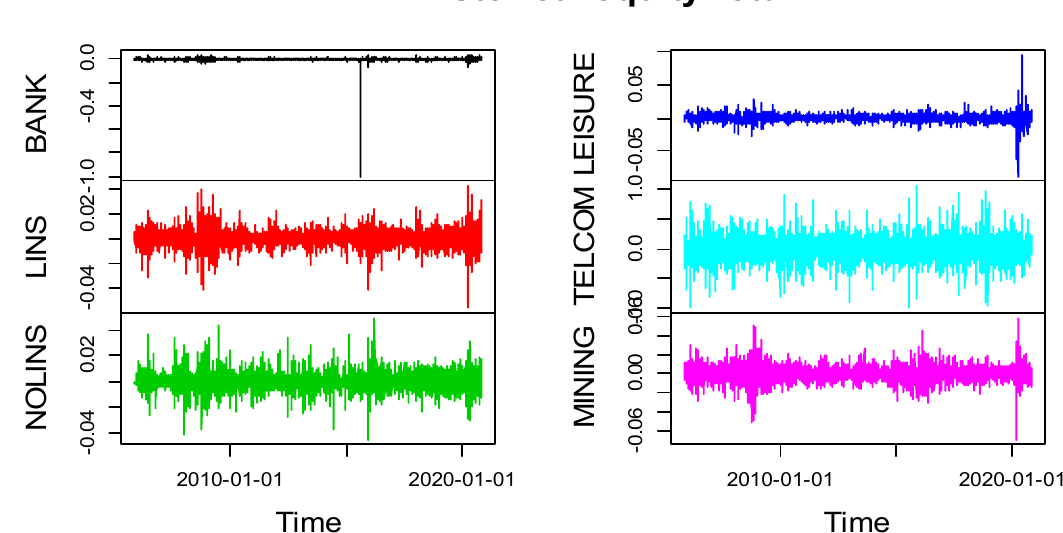
Figure A3. Daily historical stock indices. Note: Figure A3 displays a plot of daily equity returns of the selected listed sector of the JSE before the COVID-19 pandemic (January 2005–31 December 2019). Bank represents the banking sector, LINS is a life insurance sector, NOLINS is a non-life-insurance sector, TELCOM is the telecommunications sector, and MINING and LEISURE represent the mining and leisure sectors.